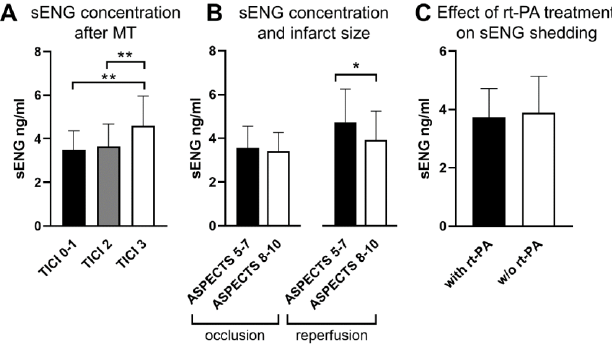
Figure 1. Concentration of sENG in venous plasma samples of stroke patients with LVO in the anterior circulation. Blood samples were drawn 18.2 ( ± 8.4) hours after MT and subjected to ELISA. In the 129 patients undergoing MT, sENG levels were significantly higher after complete (TICI 3) recanalization (TICI 0–1: n = 10, 20% received rt-PA; TICI 2: n = 94, 38.5% received rt-PA; TICI 3: n = 25, and 60% received rt-PA; there was no significant difference in the ASPECT scores between these groups) ( A ). In patients with successful recanalization, larger infarct volumes, as reflected by a lower ASPECT score at admission, resulted in increased sENG concentrations (148 patients including 19 without MT) ( B ). Application of rt-PA alone or in addition to MT did not influence